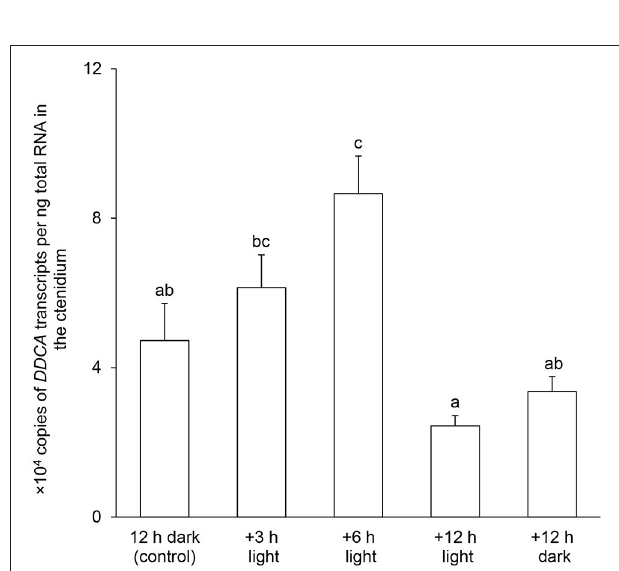
FIGURE 4 | Effects of light on the mRNA expression level of Dual Domain Carbonic Anhydrase ( DDCA ) in the ctenidium of Tridacna squamosa. Absolute quantification ( × 10 4 copies of transcript per ng of total RNA) of DDCA transcripts in the ctenidium of T. squamosa kept in darkness for 12h (control), or exposed to light for 3, 6 or 12h, or kept in darkness for another 12h (a total of 24h in darkness). Results represent means + S.E.M. ( N = 4). Means not sharing the same letters are significantly different from each other ( P <